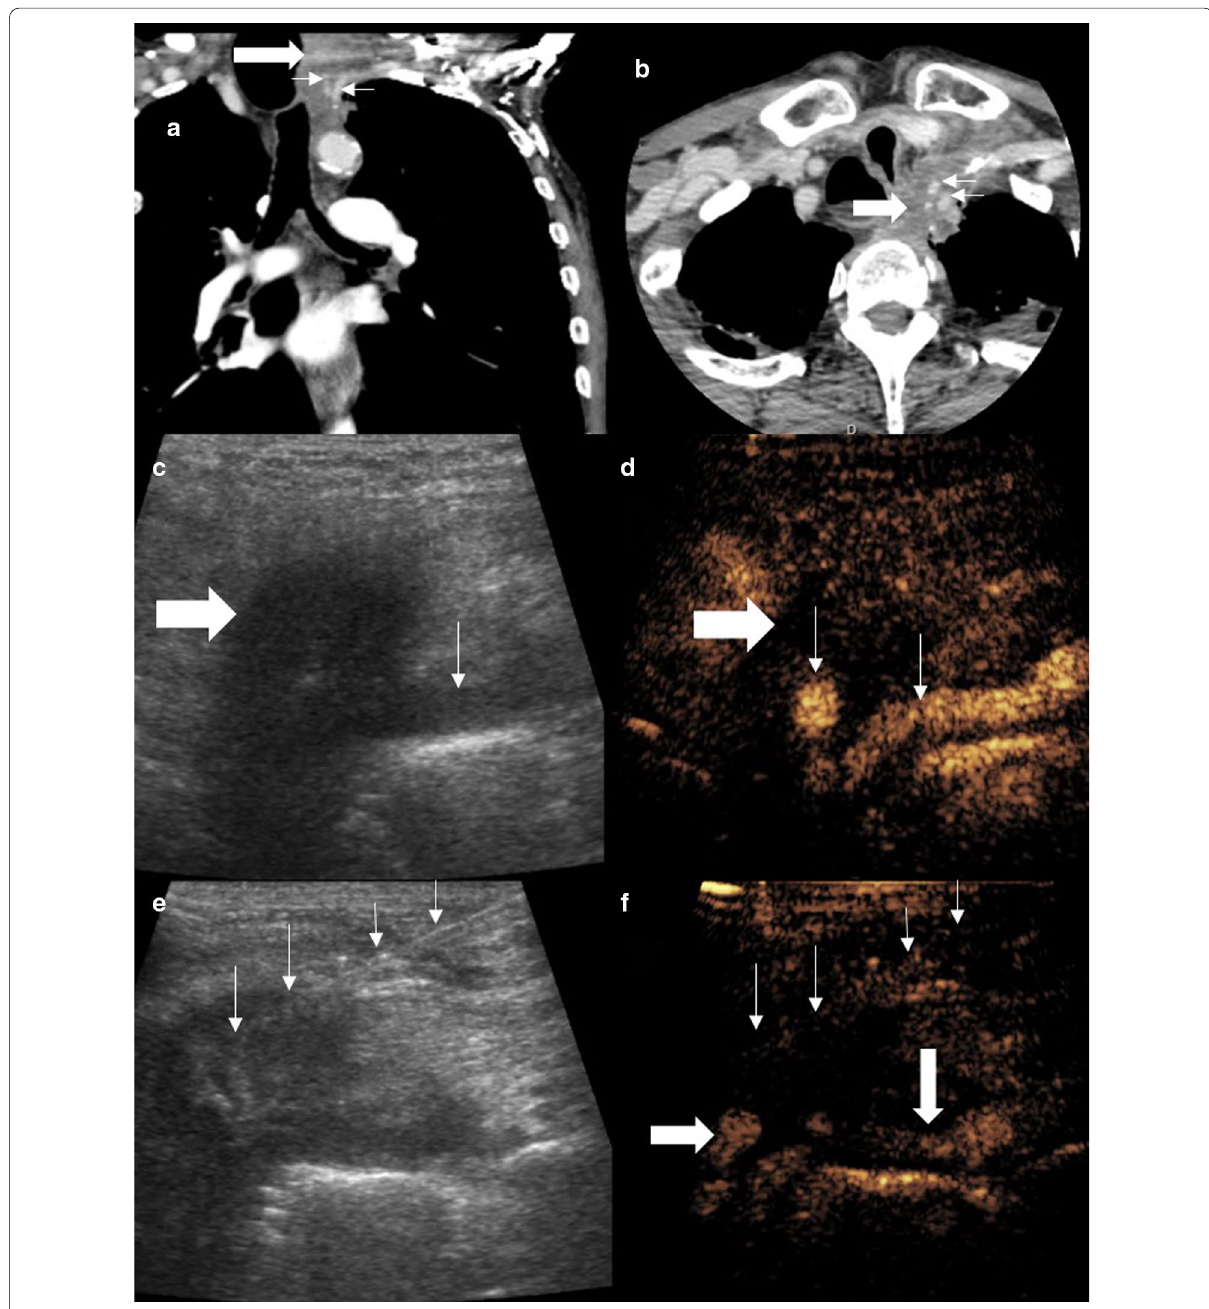
Fig. 8 Patient with Pancoast adenocarcinoma of the lung. Coronal ( a ) and axial ( b ) views show soft tissue density (thick arrows) encasing the left carotid artery and subclavian artery (thin arrows). c The tumour is seen as a hypoechoic area, ill‑defined on B mode ultrasound with the subclavian artery visible on the periphery (thin arrow). d Simultaneous CEUS clearly defines the hypoenhancing lesion and the previously unseen carotid artery and subclavian artery (thin arrows). e , f Simultaneous B mode ultrasound and CEUS with the biopsy needle (thin arrows) within the hypoenhancing lesion avoiding the critical arterial structures